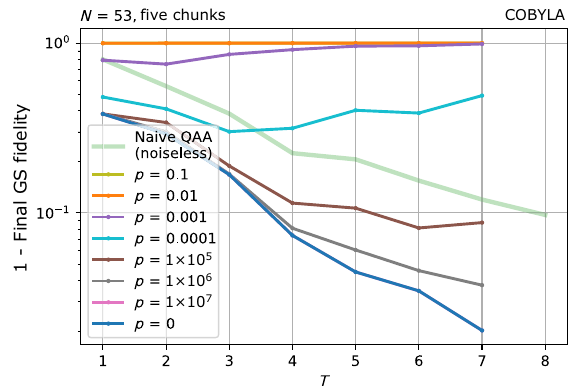
FIG. 16. The noisy benchmark of the black-box algorithm for N = 53, J = 1, and a maximum of seven optimizer iterations. The noise strength p determines the expected number of noisy qubits. Noise is applied in the circuit both in training and in the testing phase. The pink curve ( p = 10 − 7 ) lies behind the blue curve due to the very rare noise events (cf. the Supplemental Material [26]). No measurement noise is considered and naive QAA is given as a reference without noise. COBYLA is used as the classical